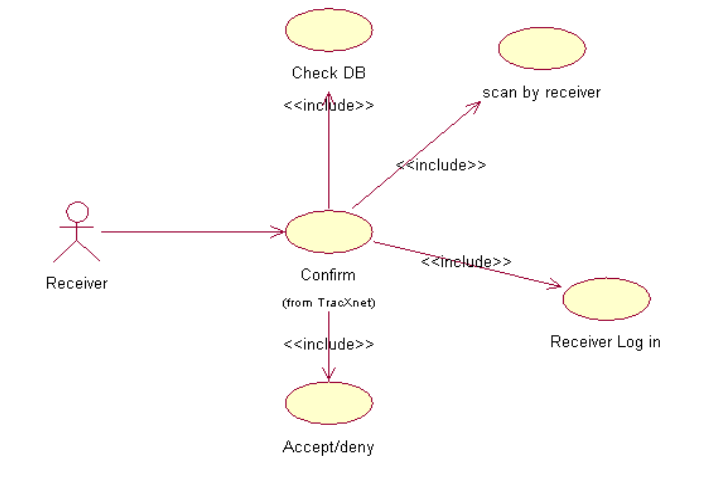
Figure 2. Use-case diagram shows the required activities of receiver